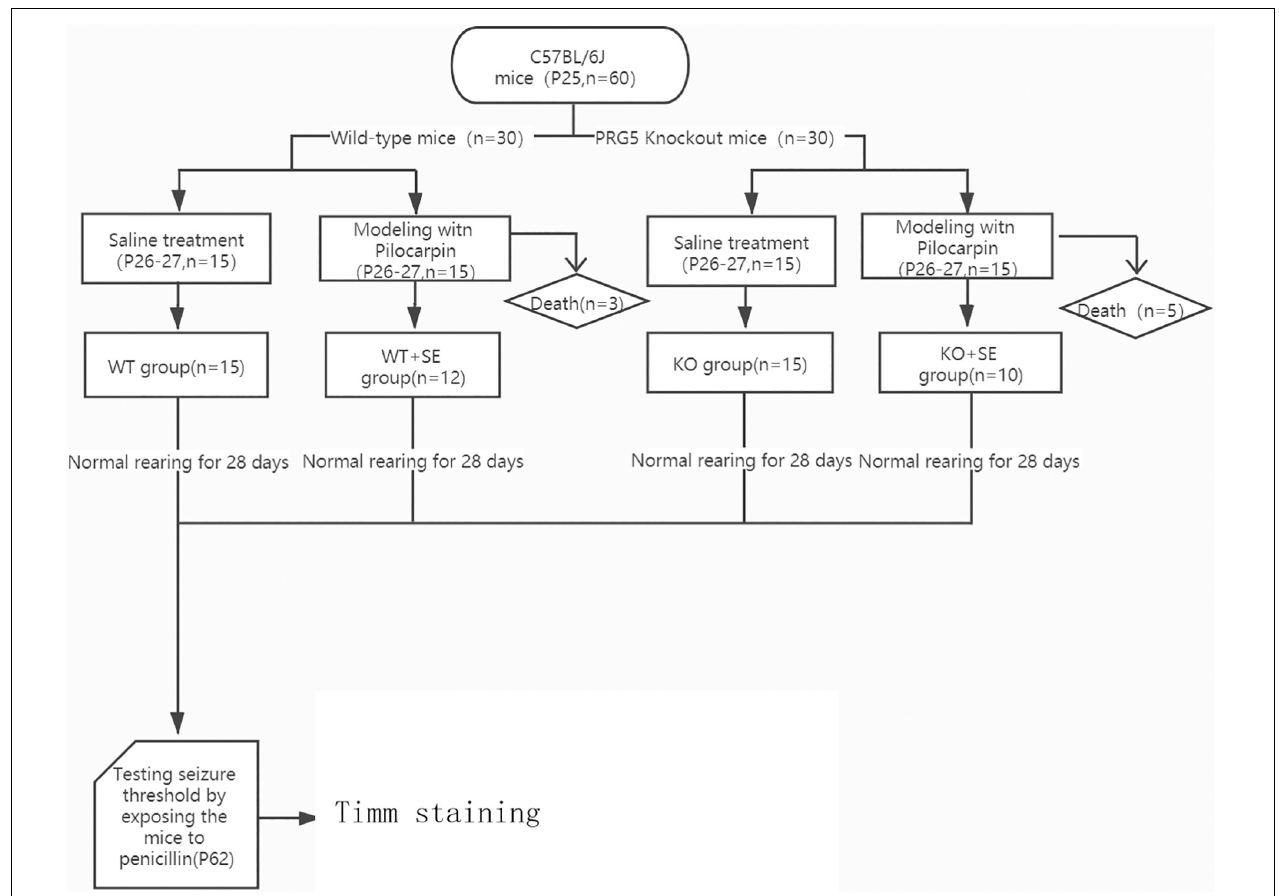
FIGURE 1 | Schematic diagram of the experimental